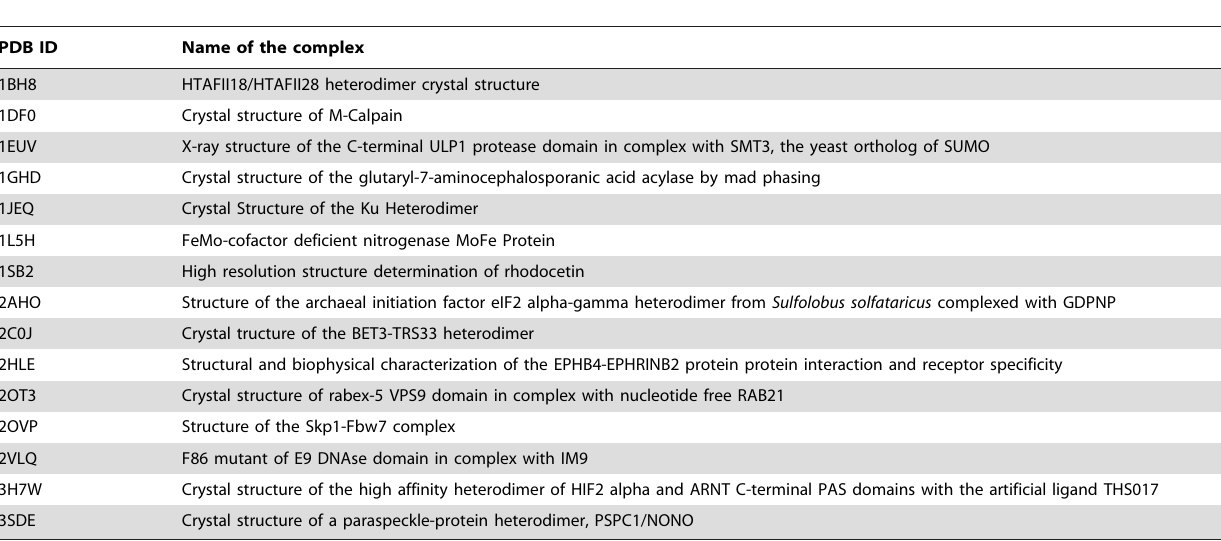
Table 5. List of 15 heterodimers (chain A and B) used for testing